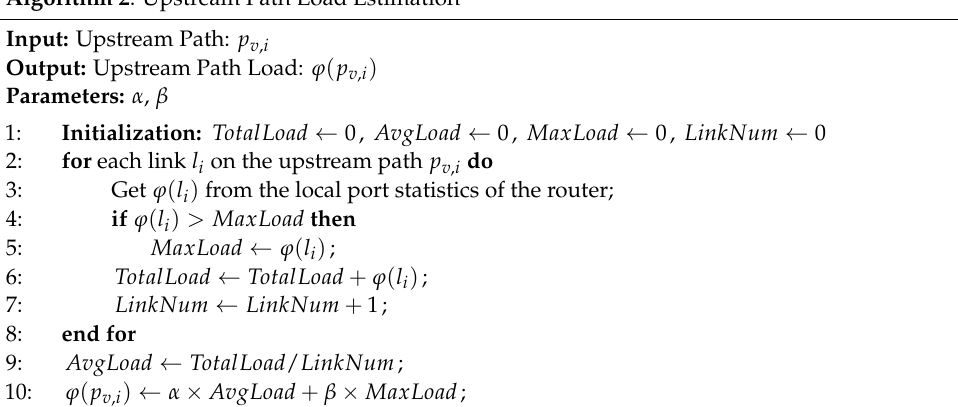
Algorithm 2 : Upstream Path Load